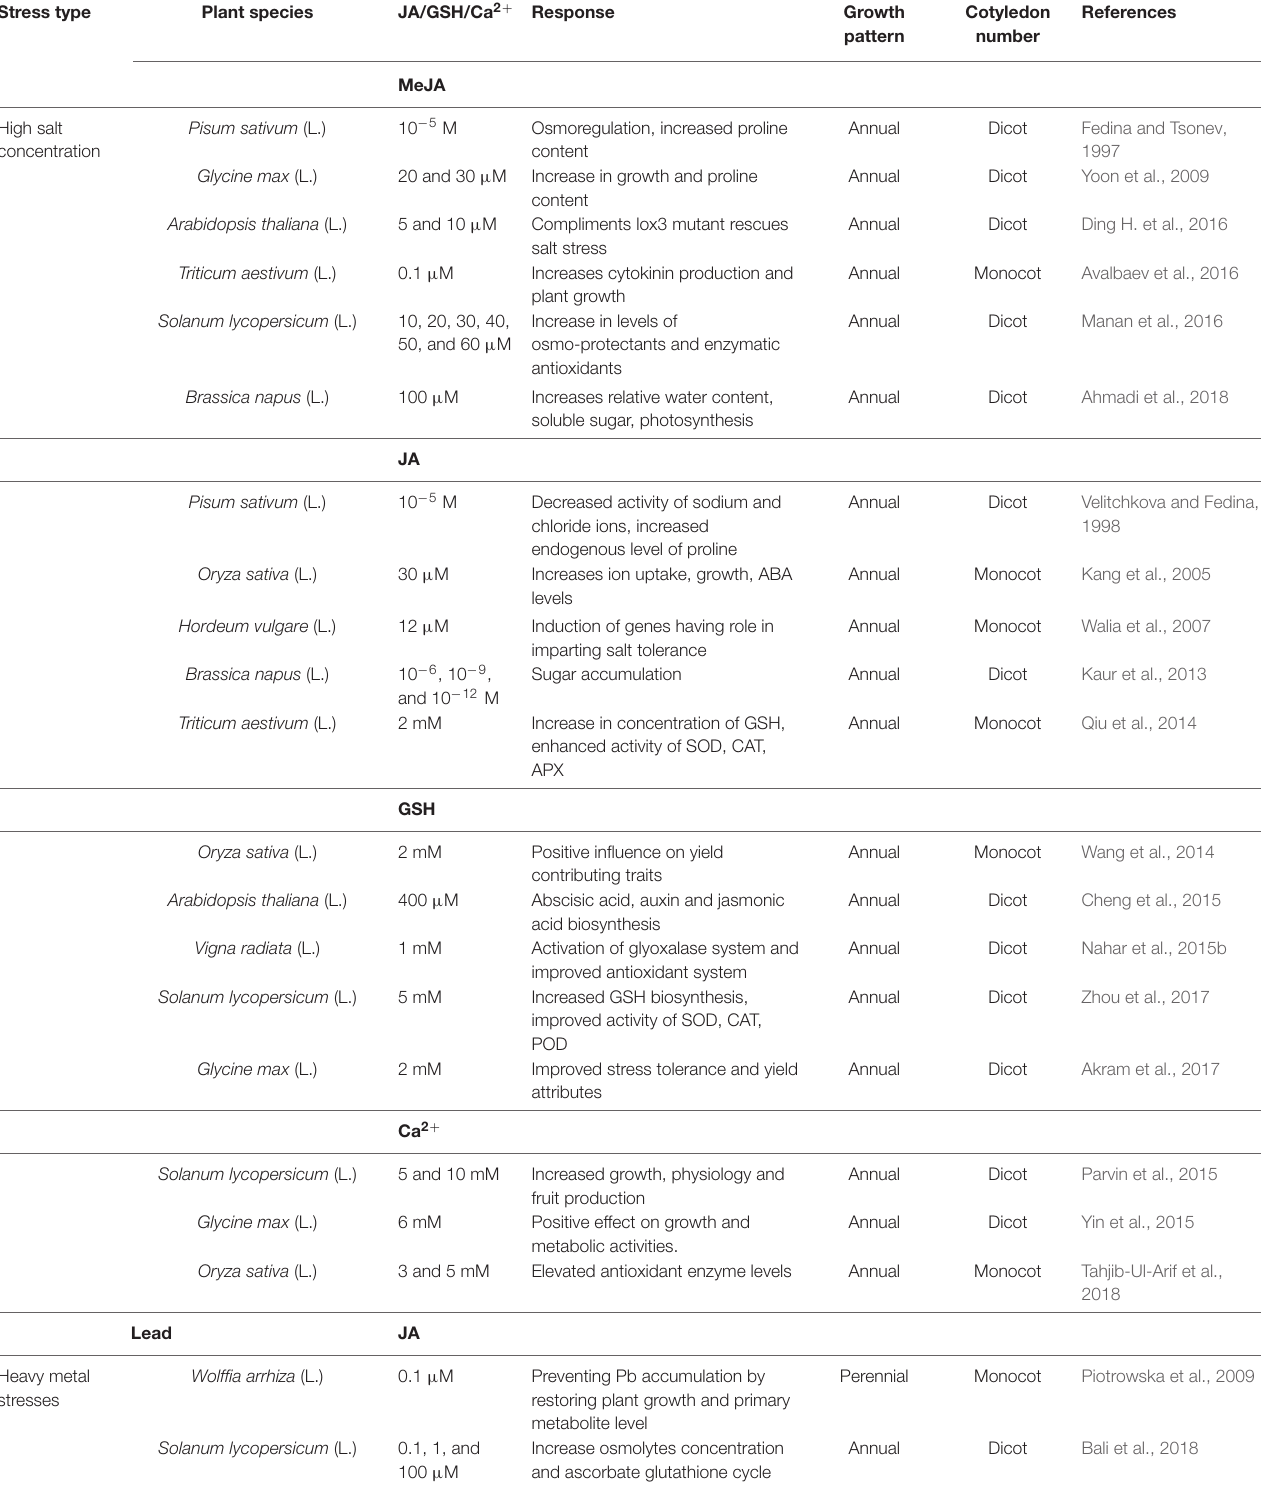
TABLE 1 | Abiotic stress response in relation with JA, Ca 2 + , and GSH among different plant